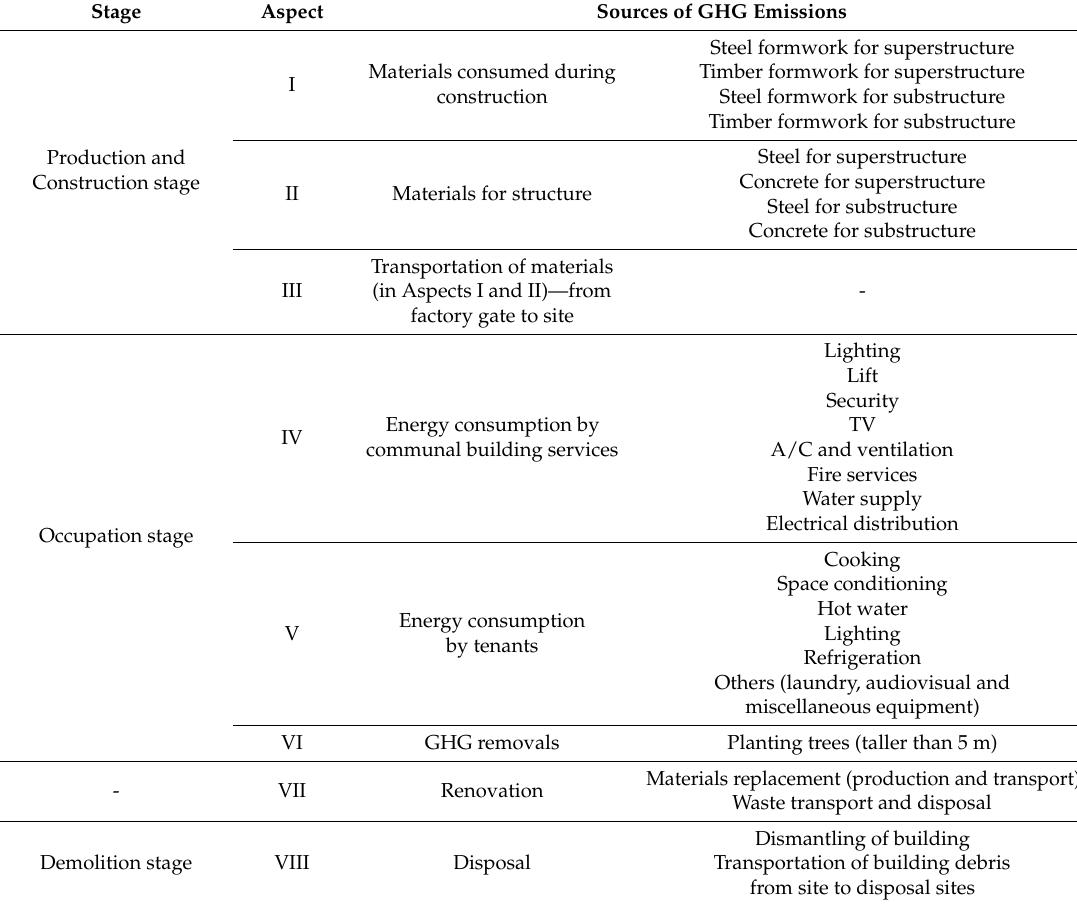
Table 1. Study scope and system boundary of the greenhouse gas (GHG)